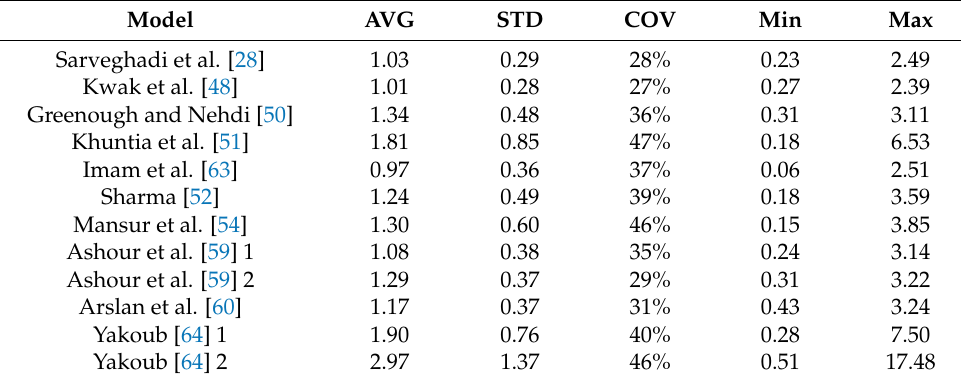
Figure 4. Comparison between experimental and predicted shear capacities for 12 methods from the literature. Table 3. Statistical properties of V utot / V pred for all 488 datapoints, with AVG = average of V utot /V pred , STD = standard deviation on V utot /V pred , and COV = coefficient of variation of V utot /V pred .